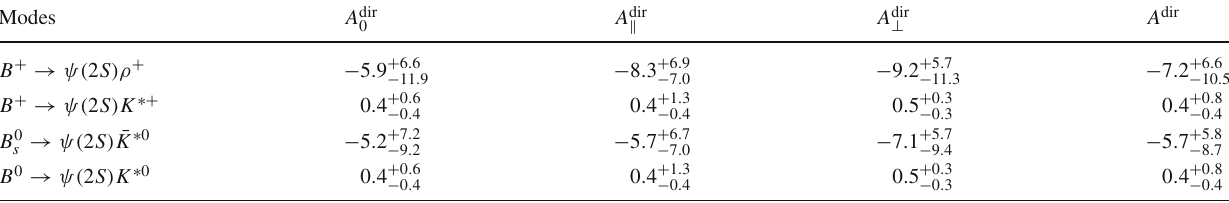
( 10 − 3 ) in the B → ψ( 2 S )(ρ + , K ∗ , ¯ K ∗ ) decays. The error arises from the hard scale t Table 3 The pQCD predictions for A dir 0 , (cid:5) , ⊥